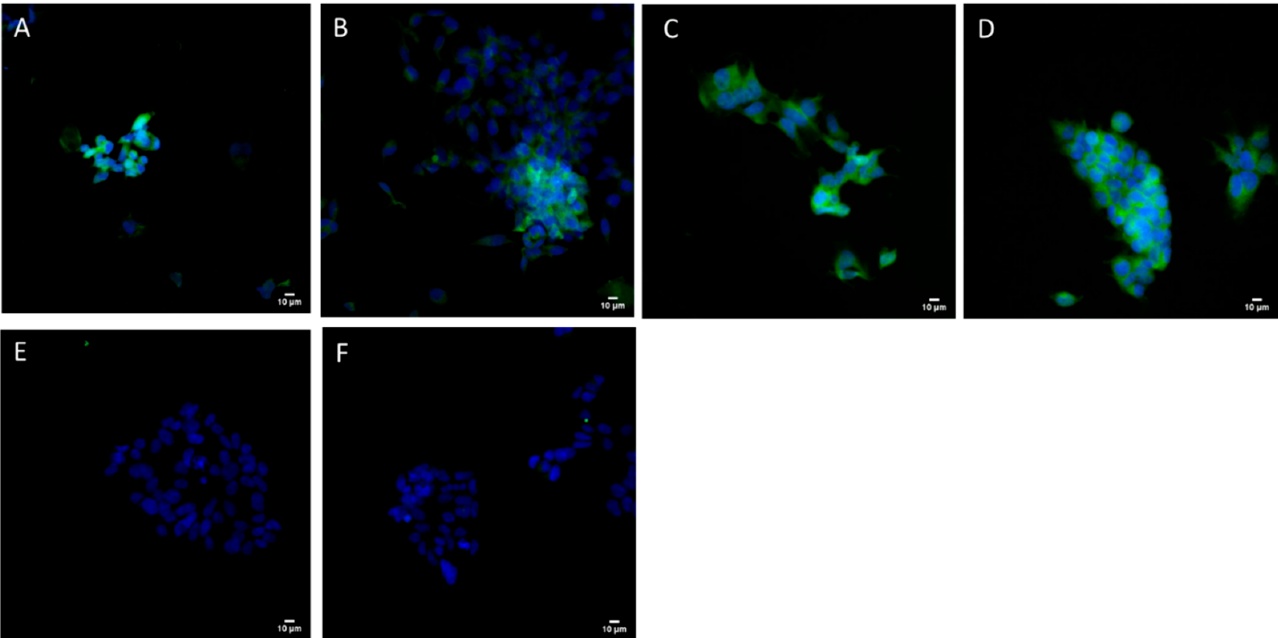
Figure 9. Intracellular SARS-CoV-2 S-protein expression. HEK293 were transfected with pCMVkan- S alone or as MF lipoplexes. ( A ) Lipofectamine/pCMVkan-S lipoplexes; ( B ) N/P 0.25:1 DOTAP4/pCMVkan-S; ( C ) N/P 1:1 DOTAP4/pCMVkan-S alone; ( D ) N/P 3.2:1